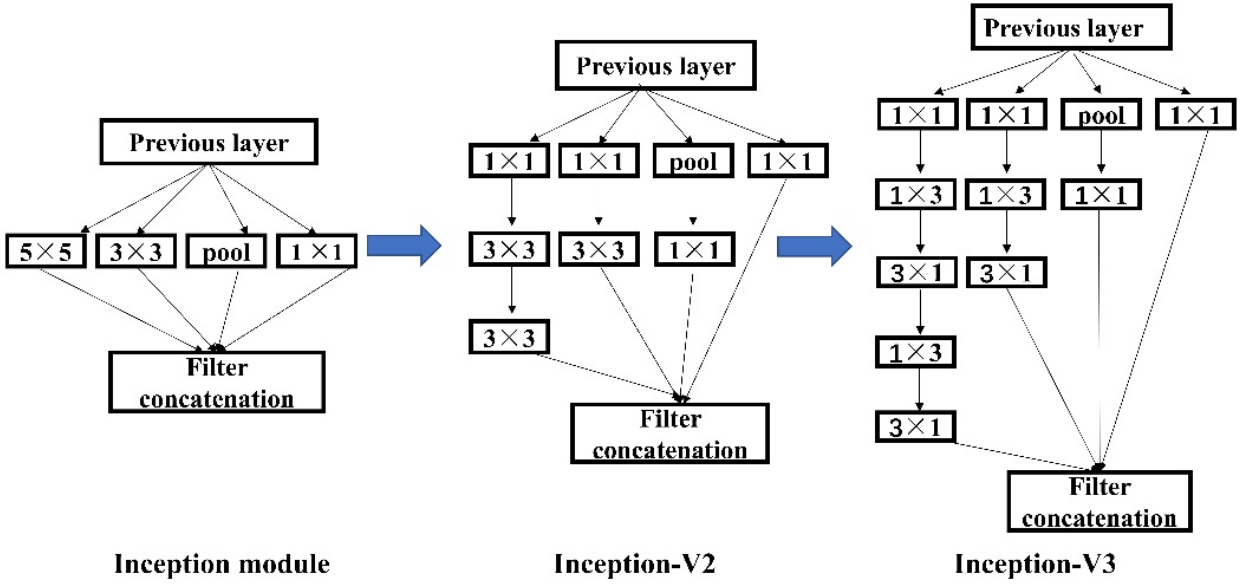
Figure 8. The optimization procedure of Inception module: ( left ), architecture of the initial Inception module; ( middle ), module architecture in Inception-V2; ( right ), module architecture in Inceptiom-V3.